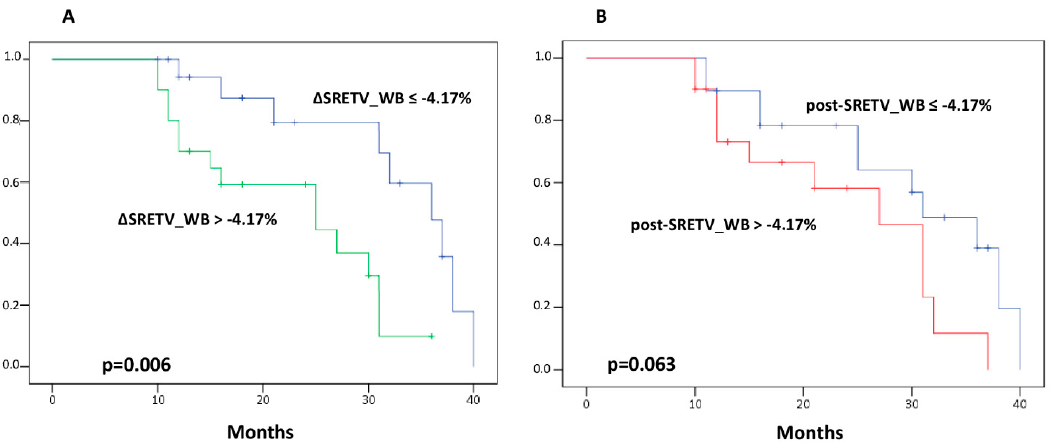
Figure 4. Progression-free survival curves with log rank test obtained for somatostatin receptor expressing tumor volume (SRETV) of total tumor burden (_WB) as percentage change ( A ) and at first restaging ( B ).